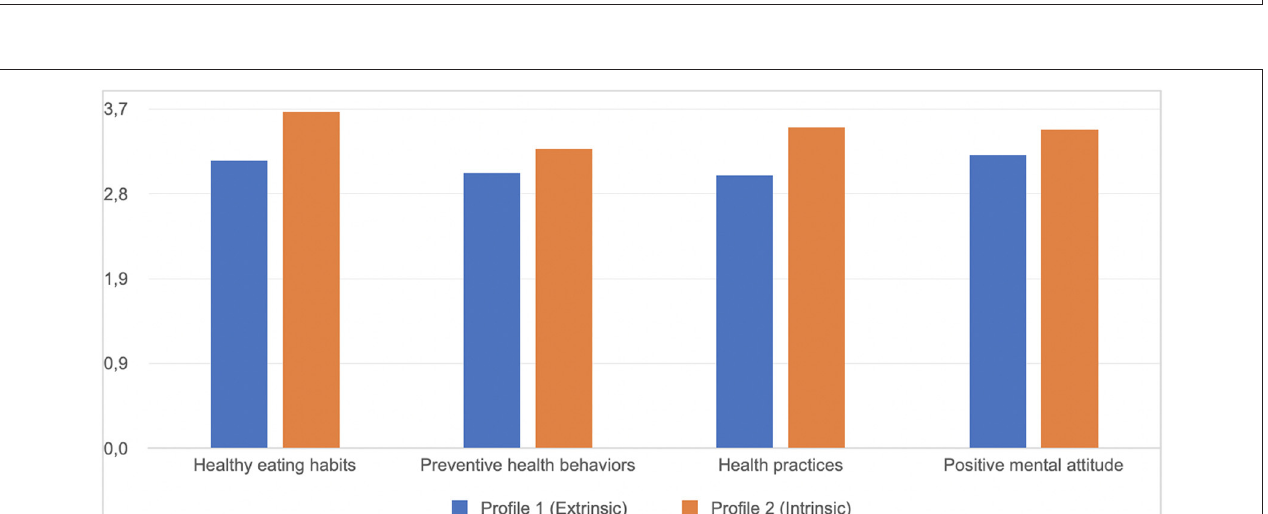
FIGURE 5 | Mean values of health-related behaviors in the two extracted classes (Study